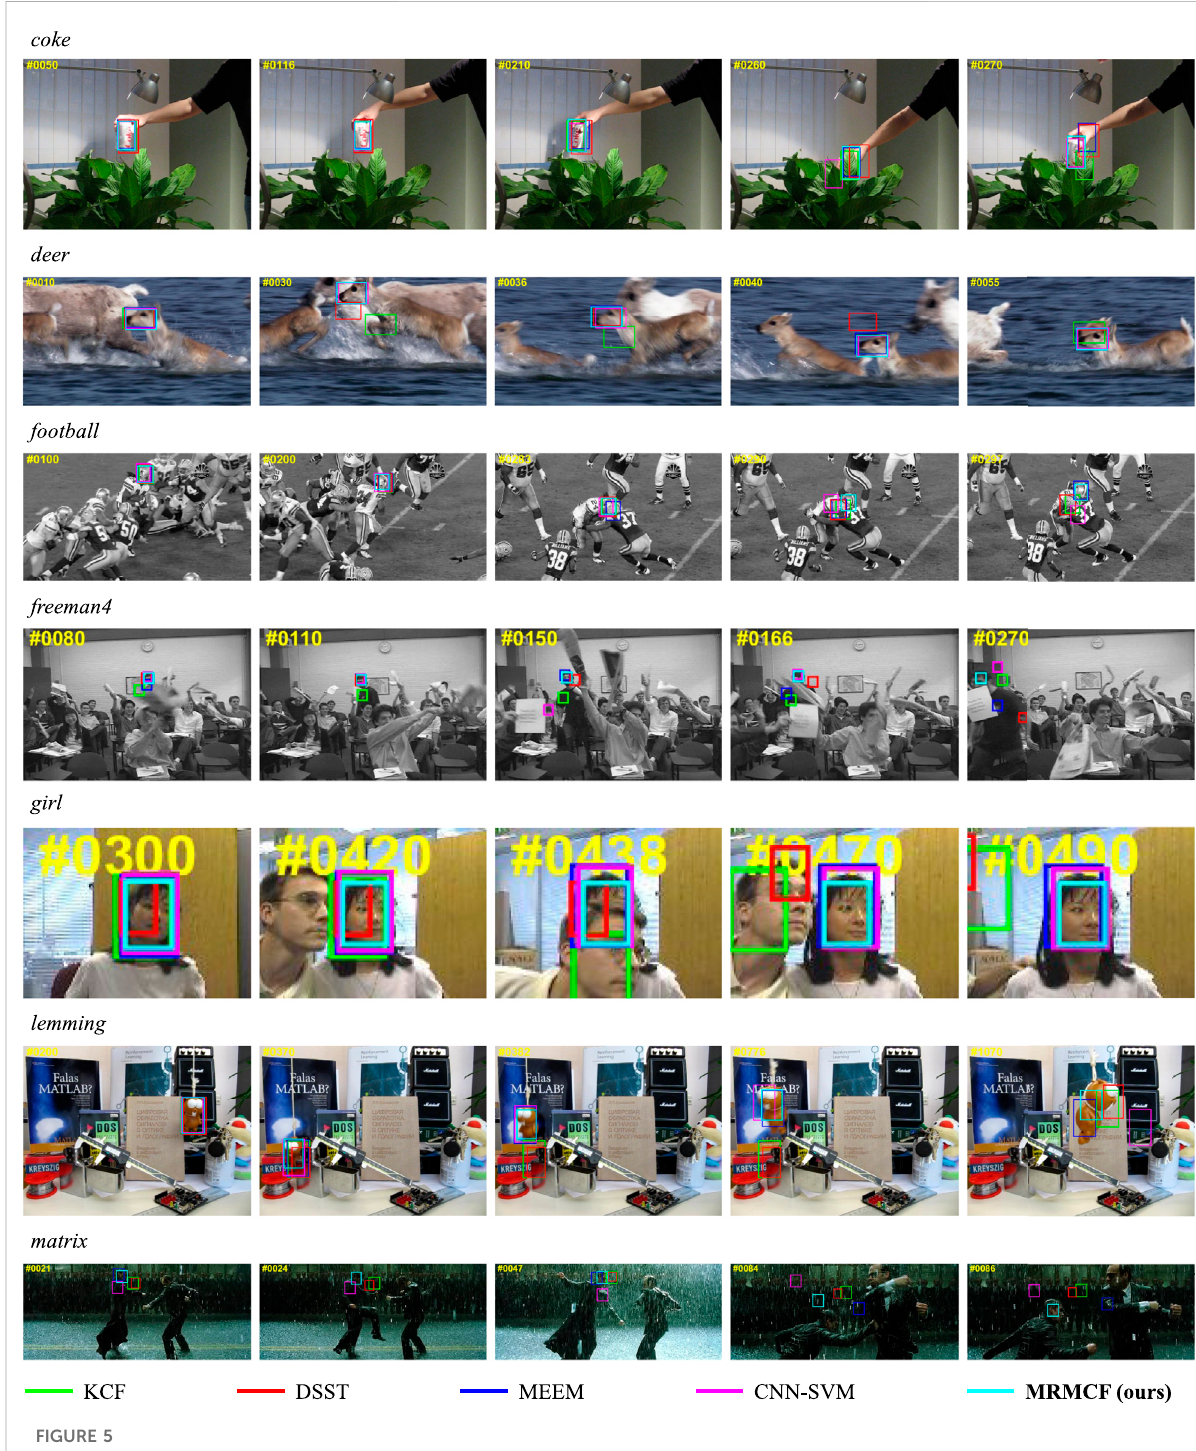
FIGURE 5 Part of tracking results of the proposed tracker and comparison trackers on the